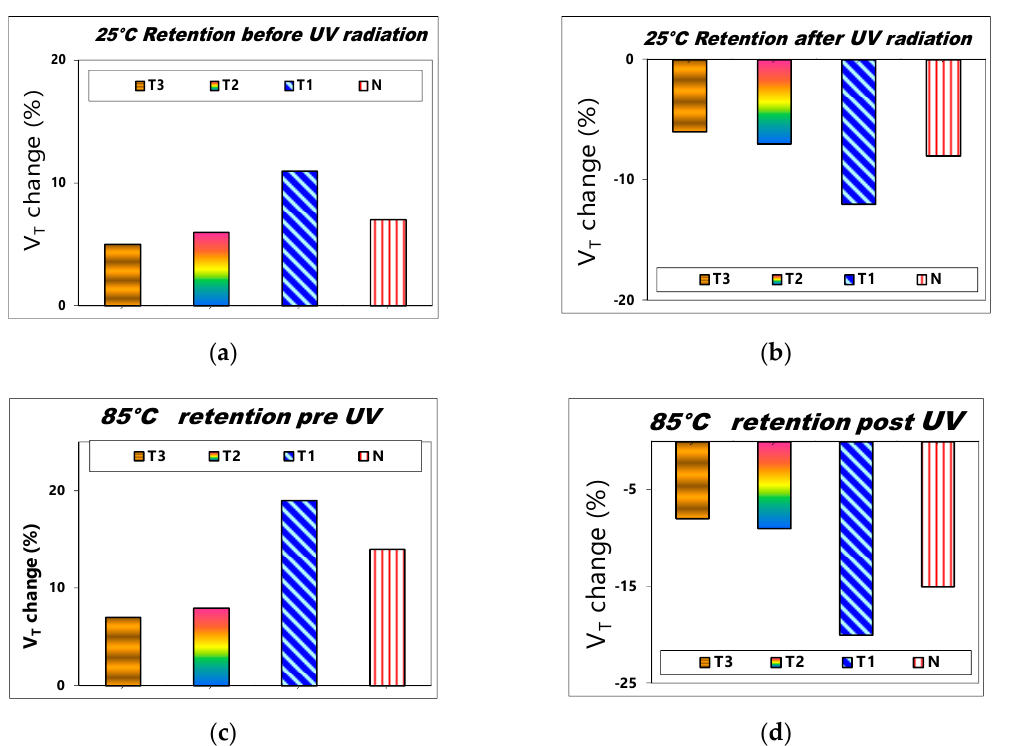
Figure 10. The comparison of V T change after a 10-years retention for various SAHAOS and SANOS with different PMA temperatures ( a ) before UV irradiation at 25°C; ( b ) after UV100G30 irradiation at 25°C; ( c ) before UV irradiation at 85°C; ( d ) after UV100G30 irradiation at 85°C.